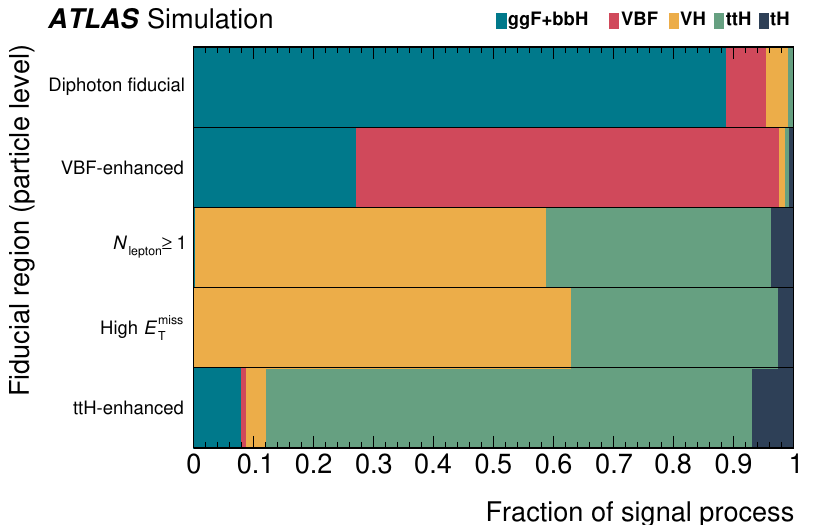
Figure 1. The expected production mode composition of Higgs boson events in each fiducial region at particle level, as estimated from simulated SM Higgs boson events with m